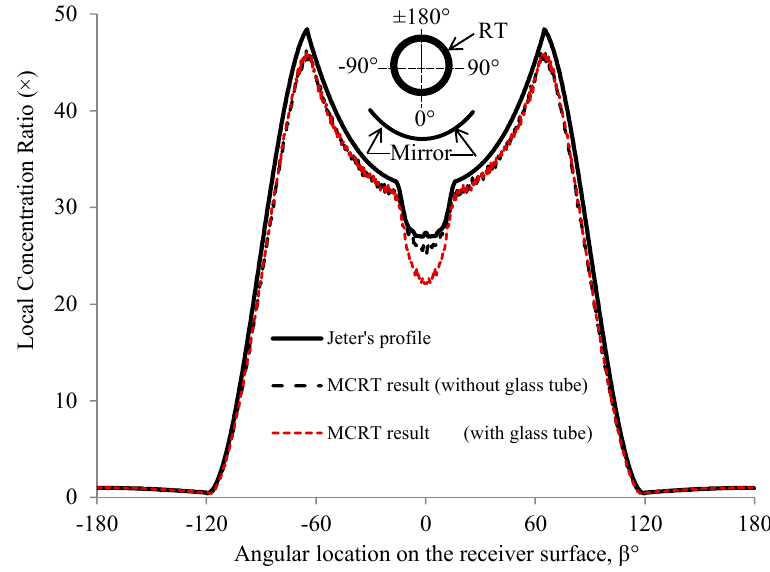
Figure 4. Comparison of calculated LCR profiles around the receiver tube (RT) of a typical PTC with Jeter’s LCR profile.